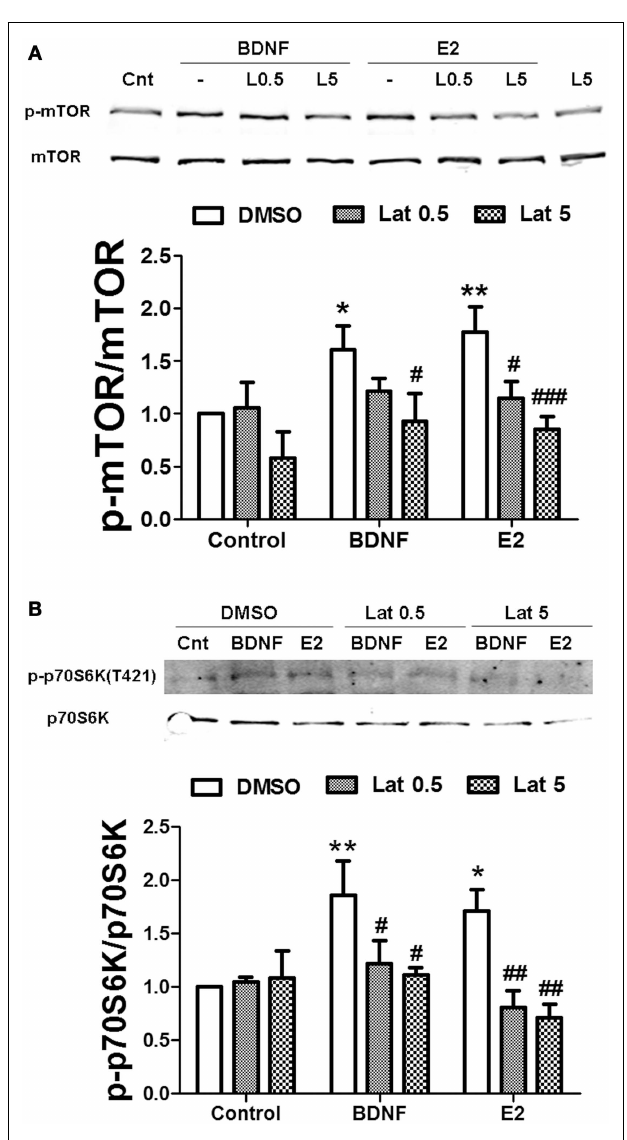
FIGURE 8 | Estradiol-induced mTOR-dependent and mTOR–independent protein translation requires actin polymerization . Acute hippocampal slices were pre-treated with DMSO (Cnt) or Latruncullin A (Lat, 0.5–5 µ M) for 30min and then incubated with estradiol (E2, 10nM) or BDNF (BD, 100ng/ml) for an additional 30min. At the end of treatments, slices were homogenized and processed for western blot. Data are presented as the ratio (fold of control) of: (A) p-mTOR over total mTOR ( N = 4–5), (B) p-p70S6K (T421/S424) over total p70S6K ( N = 4); * p < 0.05, ** p < 0.01, as compared to control (DMSO); # p < 0.05, ## p < 0.01, ### p < 0.001, as compared to E2 or BDNF alone (two-way ANOVA).